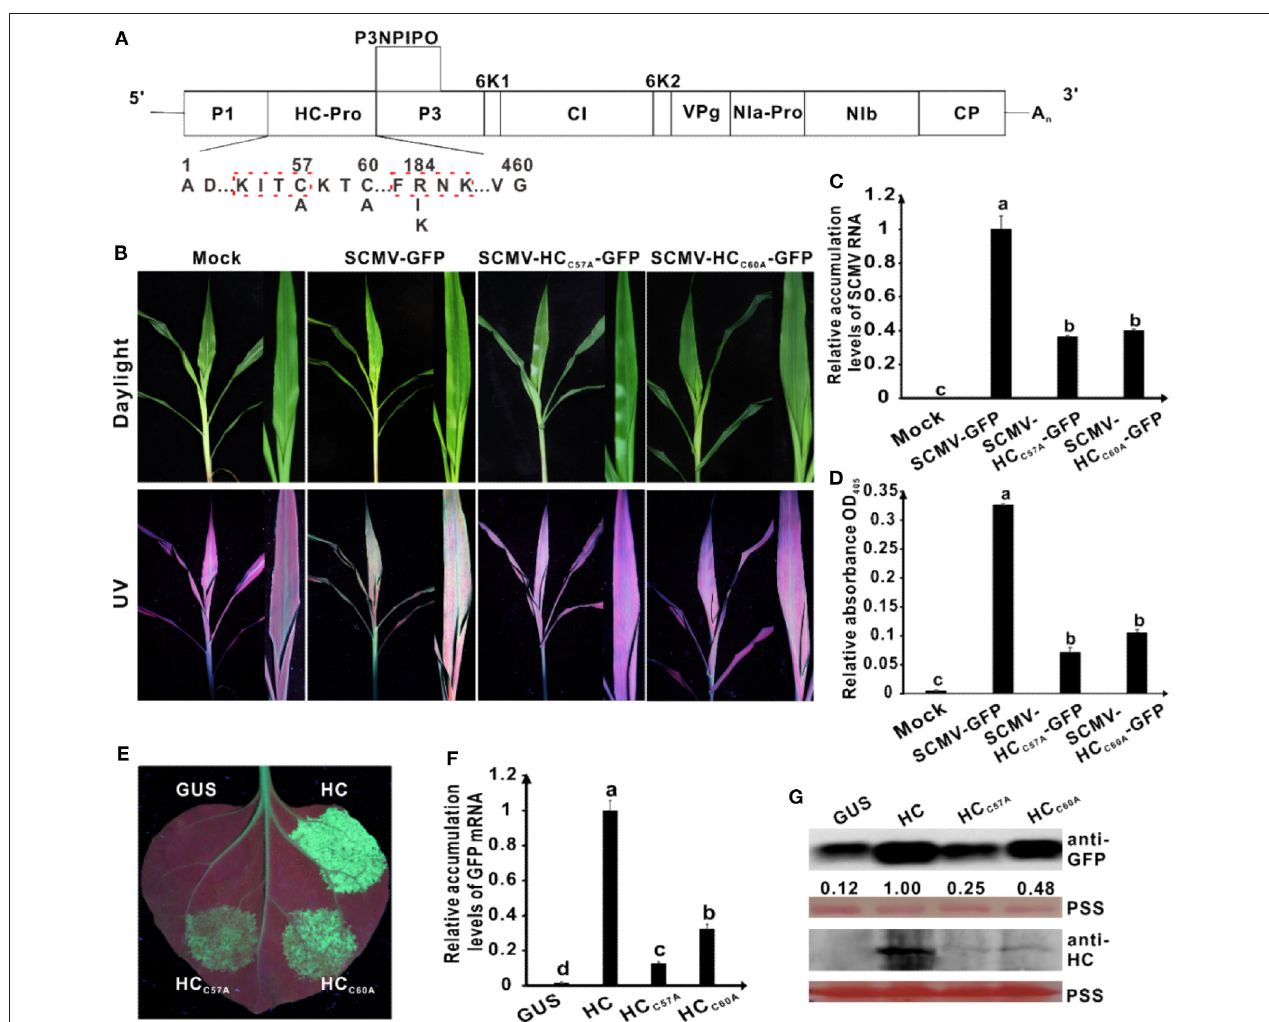
FIGURE 2 | Effects of the mutations in the conserved C 57 and C 60 of wild type HC-Pro on its RNA silencing suppression activity and virulence of SCMV. (A) Genetic map of SCMV, showing the all mutations in HC-Pro. The numbers above the sequence indicate their position in SCMV HC-Pro and the letters below the sequence showed the substituted residues at that position. The highly conserved KITC and FRNK motifs in SCMV HC-Pro were marked by the red dotted boxs. (B) Symptoms of SCMV and two SCMV mutants in maize plants at 10 days post inoculation (dpi). The conserved C 57 and C 60 in wild type SCMV HC-Pro were mutated to A residues in HC-Pros of SCMV-HC C 57 A -GFP and SCMV-HC C 60 A -GFP, respectively. Mock, the maize plants inoculated with the empty vector pCB301-Rz. SCMV-GFP, the maize plants infected with wild type SCMV with gfp reporter gene. (C) The wild type and mutant SCMV RNA accumulation levels in the upper leaves of maize plants at 10 dpi. (D) ELISA analysis of the wild type and mutant SCMV accumulation levels in the upper leaves of maize plants at 10 dpi. (E) The wild type and mutants HC-Pro RSS activity in Agrobacterium co-infiltration assay. The N. benthamiana 16C leaves were infiltrated with a mixture of Agrobacterium cultures carrying pBin-GFP and either wild type or mutant HC-Pro and photographed under long-wavelength UV light at 3 days post agroinfiltration (dpai). The conserved C residues in wild type HC-Pro (HC) were mutated to A residues in HC C 57 A and HC C 60 A , respectively. The GUS was used as a negative control. (F) The GFP mRNA accumulation levels in agroinfiltrated 16C leaf patches. (G) Western blotting analysis of the accumulation levels of GFP and HC in agroinfiltrated leaf patches of 16C. The ponceau S staining (PSS) shows sample loadings. Band intensities were measured using the ImageJ software. Numbers indicate the accumulation levels of SCMV CP normalized to PSS staining. Error bars indicate the means ± standard deviation of three replicates. Statistical significance was determined by employing Tukey multiple range test for between-group comparisons. Different letters indicate significant differences ( P < 0.05). The same below. The experiments were repeated thrice independently.